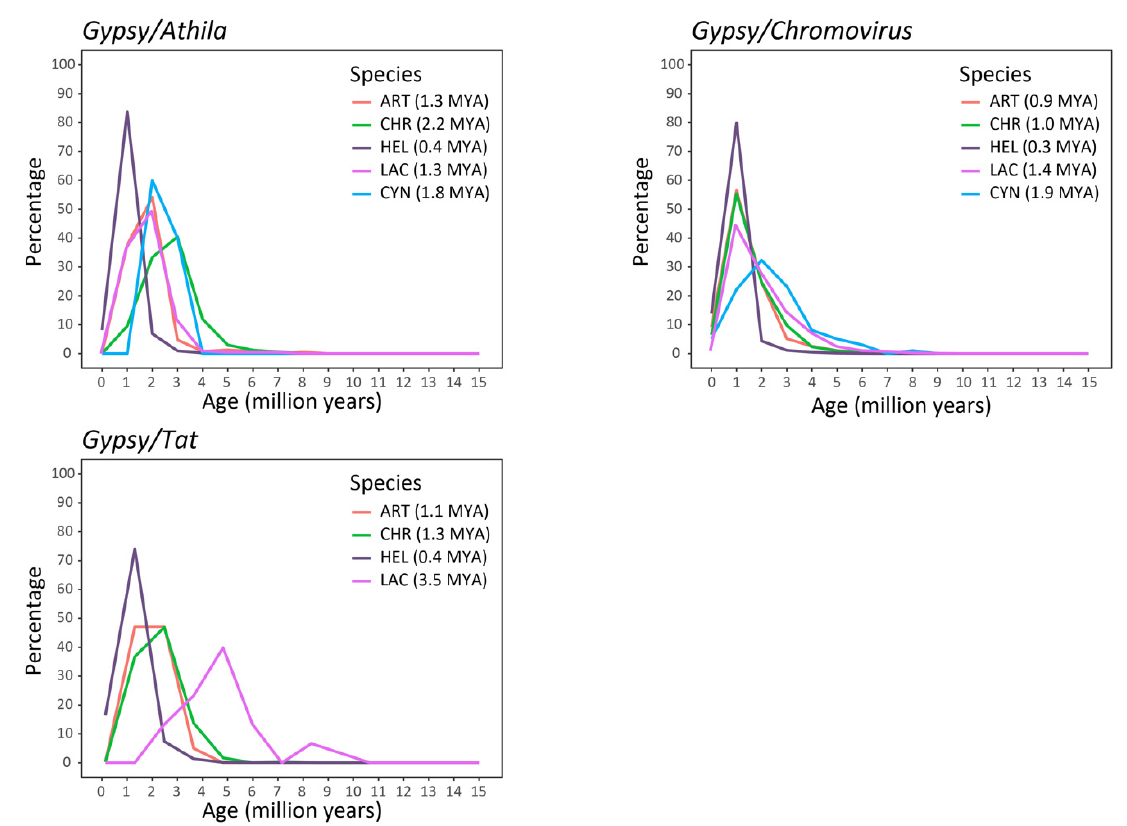
Figure 7. Insertion time of Gypsy elements in the five Asteraceae species. The average insertion time (in MYA) for each species is reported in parentheses. HEL = Helianthus annuus , LAC = Lactuca sativa , CYN = Cynara cardunculus var. scolymus , ART = Artemisia annua , CHR = Chrysanthemum seticuspe .